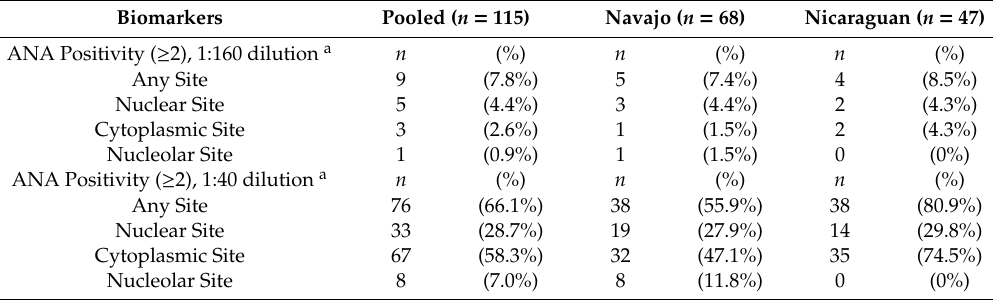
Table 2. Biomarkers of autoimmunity among the study